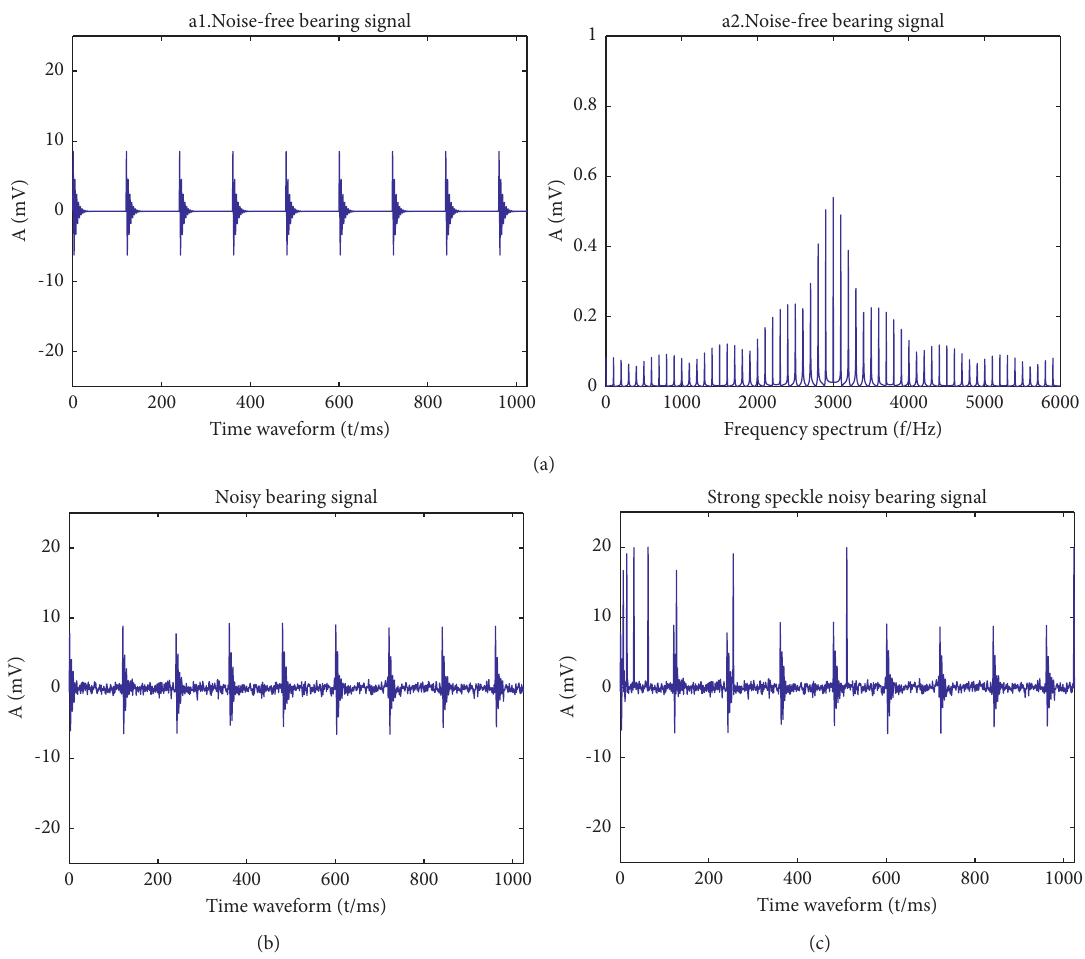
Figure 1: Simulation signal of rolling bearing. (a) Noisy-free bearing signal. (b) Noisy bearing signal. (c) Strong speckle noisy bearing